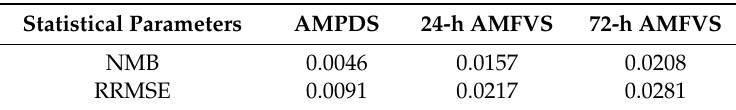
Table 7. Values of statistical parameters for all flood characteristic